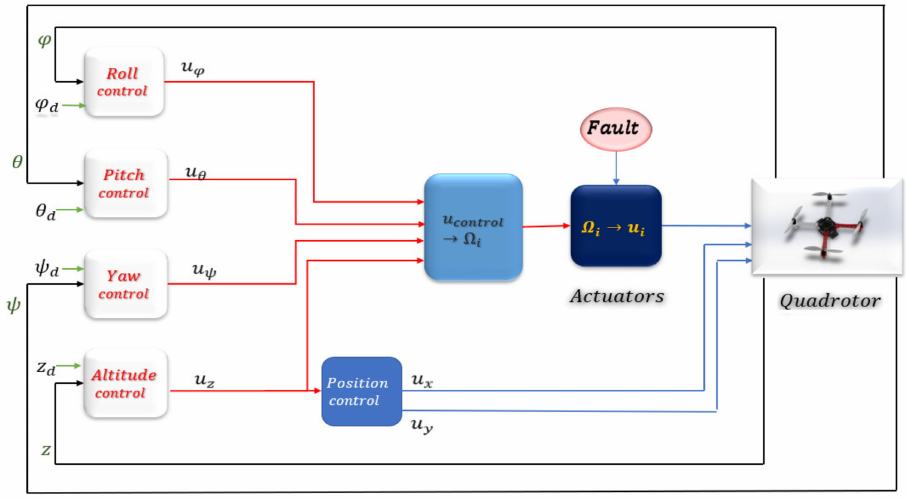
Figure 1. The control scheme of the